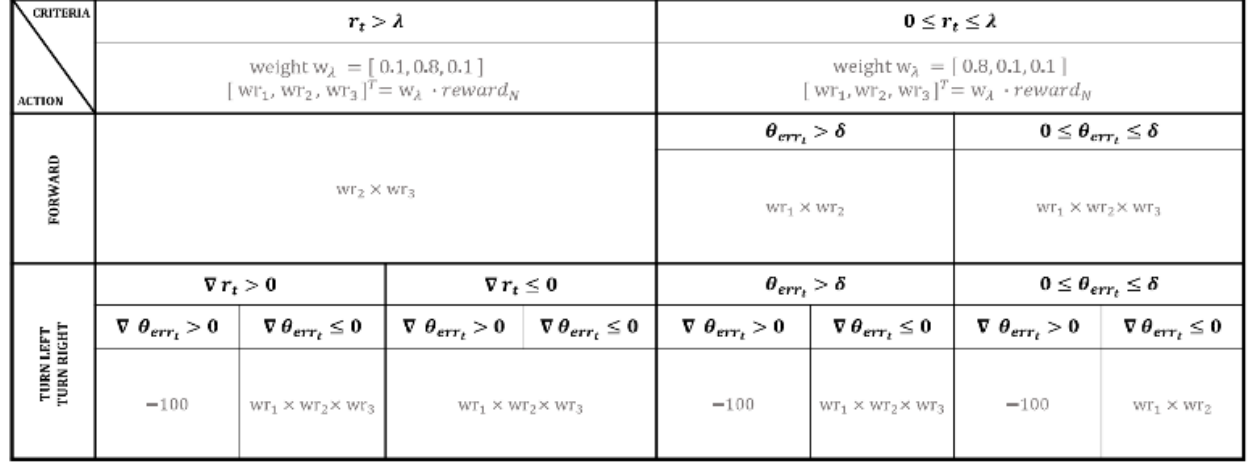
Figure 14. Reward discrimination table describing step rewards per action 𝑟𝑒𝑤𝑎𝑟𝑑